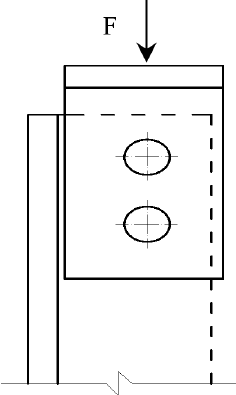
Figure 17: End constraint condition of test component